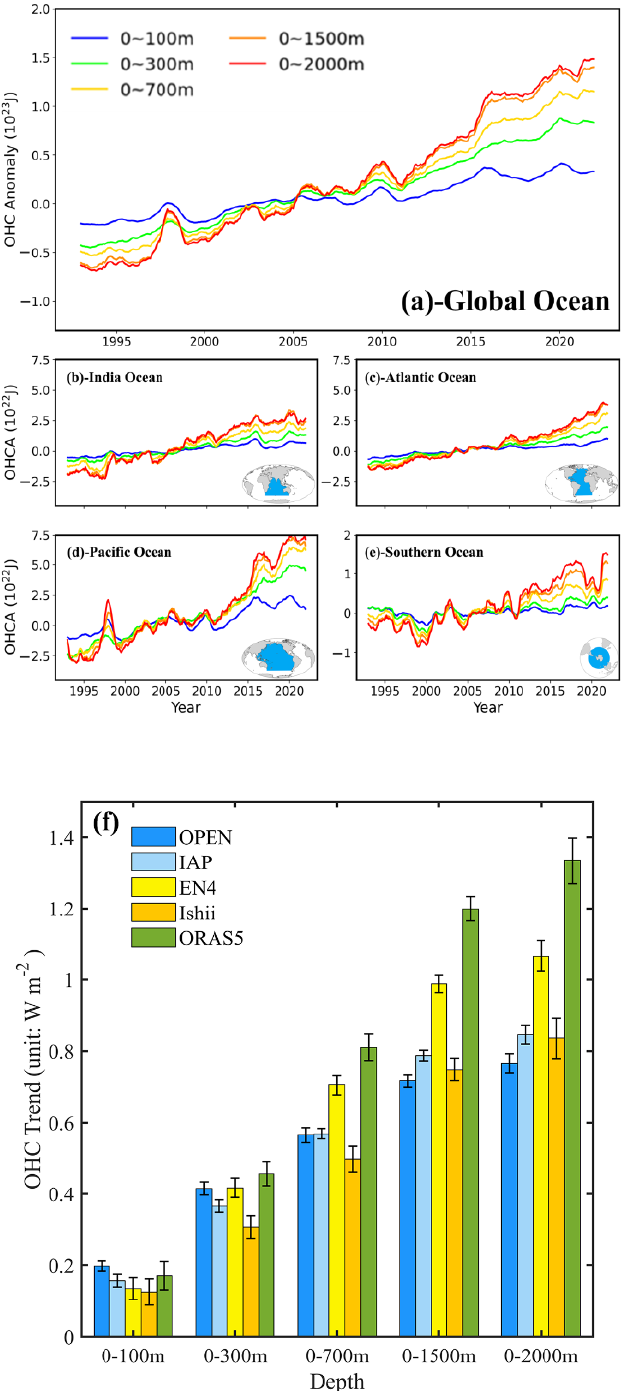
Figure 2. Time series of monthly OPEN OHC anomalies integrated from surface to different depths over the period of 1993–2021 in ( a ) the global ocean, ( b ) the Indian Ocean, ( c ) the Atlantic Ocean, ( d ) the Pacific Ocean, and ( e ) the Southern Ocean. The colored lines indicate the OHC on the left axis (unit: 10^22 J). The blue area in the inset map indicates the division of the globe into the Indian, Atlantic, Pacific, and Southern Oceans. ( f ) Global OHC trends for different depth ranges (0 – 100 m, 0 – 300 m, 0 – 700 m, 0 – 1500 m, and 0 – 2000 m) for the period of 1993 – 2021 by the five datasets (unit: W m −2 ), with error bar by two times standard deviations. The reference period for OHC anomalies is 1993 – 2015 for all the datasets.